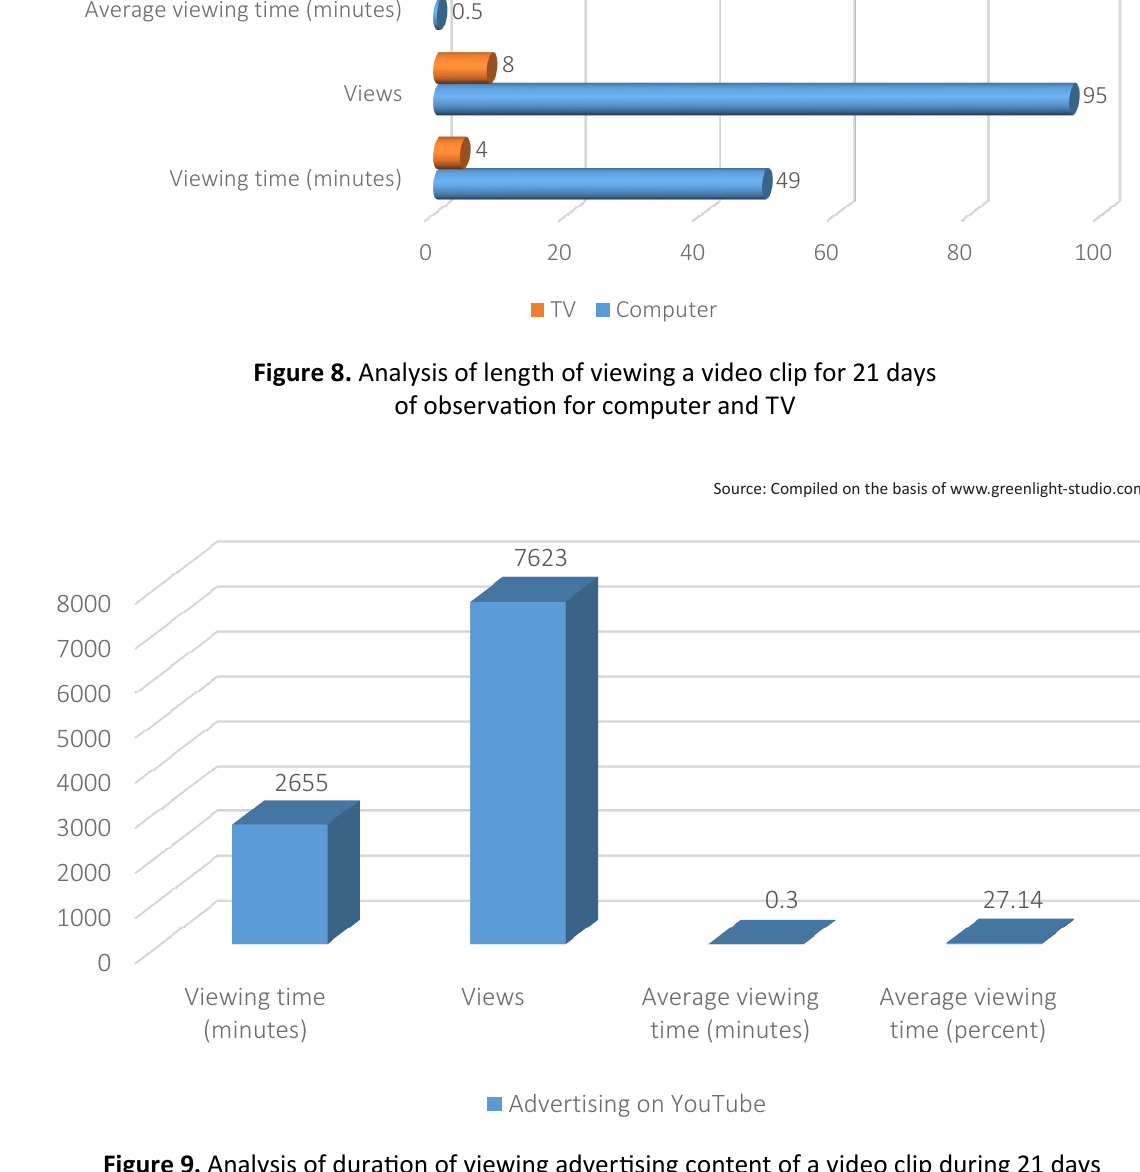
Figure 9. Analysis of duration of viewing advertising content of a video clip during 21 days of observation on